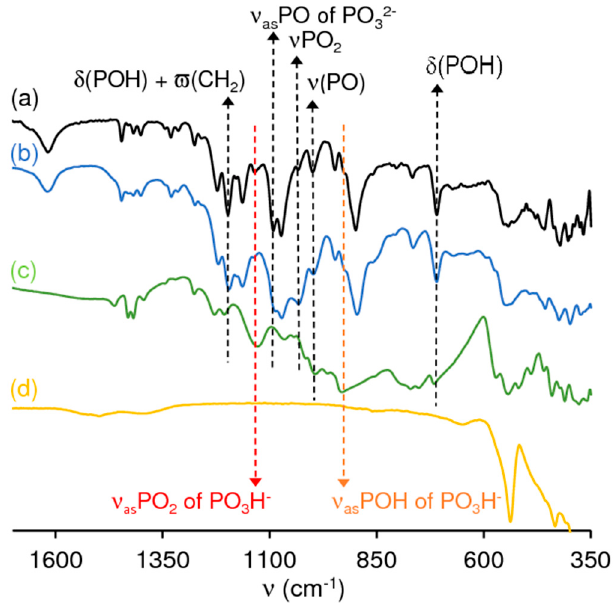
Figure 6. ATR FT-IR spectra of the fresh ( a ) and used ( b ) catalyst 1 (Fur/Gly reaction at 50 °C), and the synthesis precursors H 6 nmp ( c ) and Gd 2 O 3 ( d ).